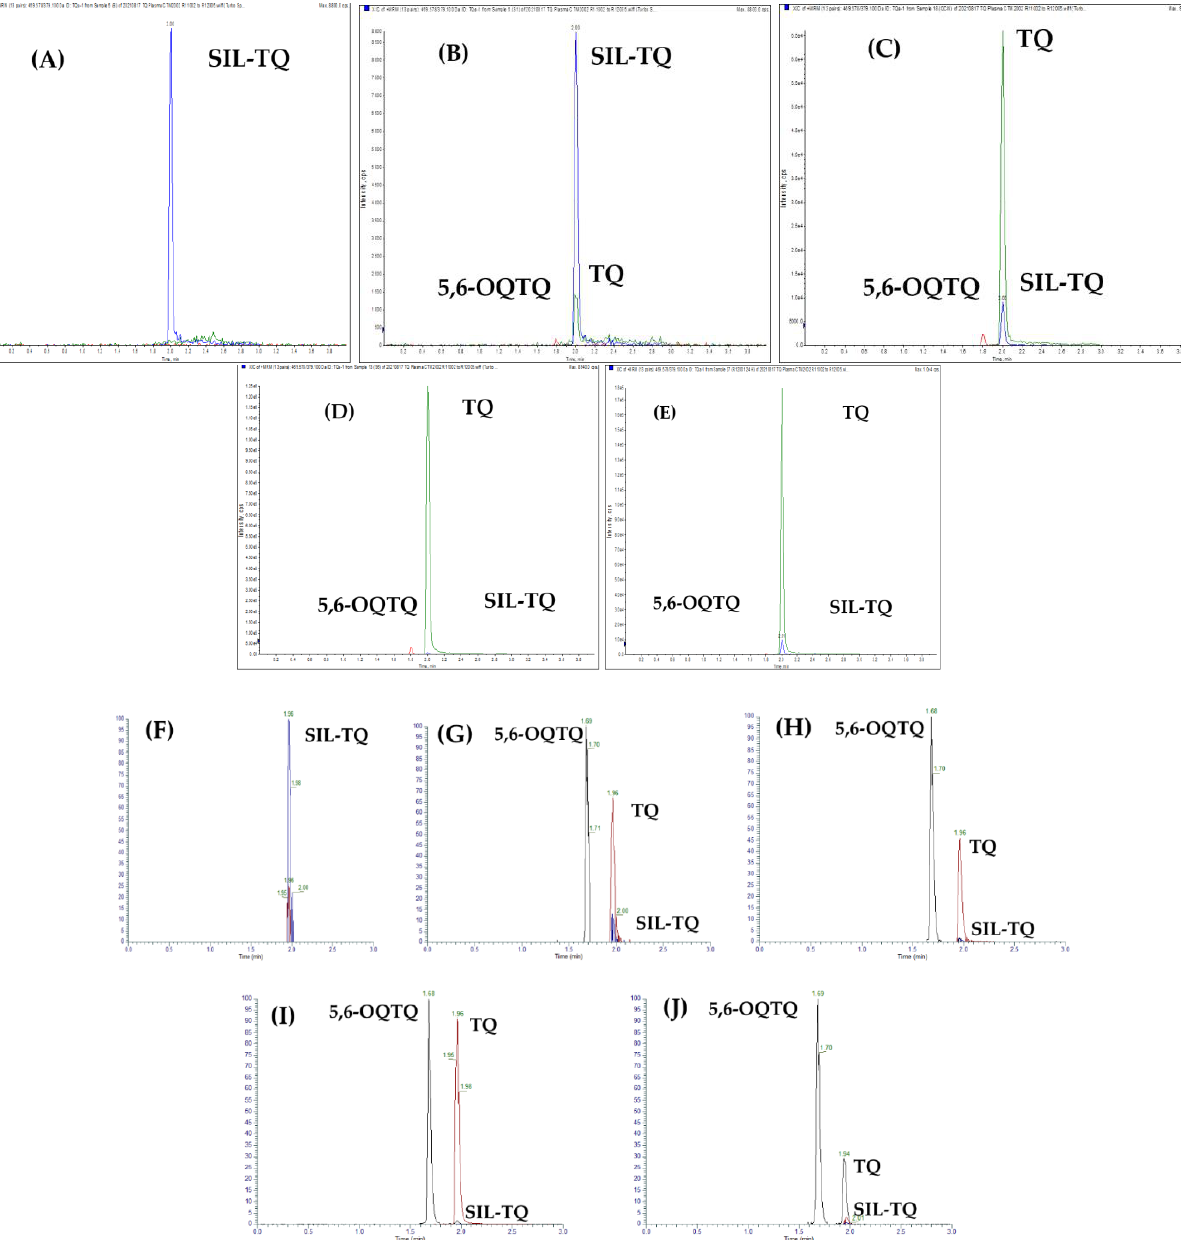
Figure 2. Chromatograms of 5,6-OQTQ, SIL-TQ and TQ in human plasma and urine. ( A ) Blank plasma with internal standard (SIL-TQ, blue peak). ( B ) Spiked plasma at low limit of quantification (LLOQ) for TQ (green peak) and 5,6-OQTQ (red peak). ( C ) Spiked plasma at 50 ng/mL TQ and 15 ng/mL 5,6-OQTQ. ( D ) Spiked plasma at 1200 ng/mL TQ and 200 ng/mL 5,6-OQTQ. ( E ) A clinical trial participant plasma sample. ( F ) Blank urine with internal standard (SIL-TQ). ( G ) Spiked urine at LLOQ for TQ and 5,6-OQTQ. ( H ) Spiked urine at 150 ng/mL TQ and 5,6-OQTQ. ( I ) Spiked urine at 1000 ng/mL TQ and 5,6-OQTQ. ( J ) A clinical trial participant urine